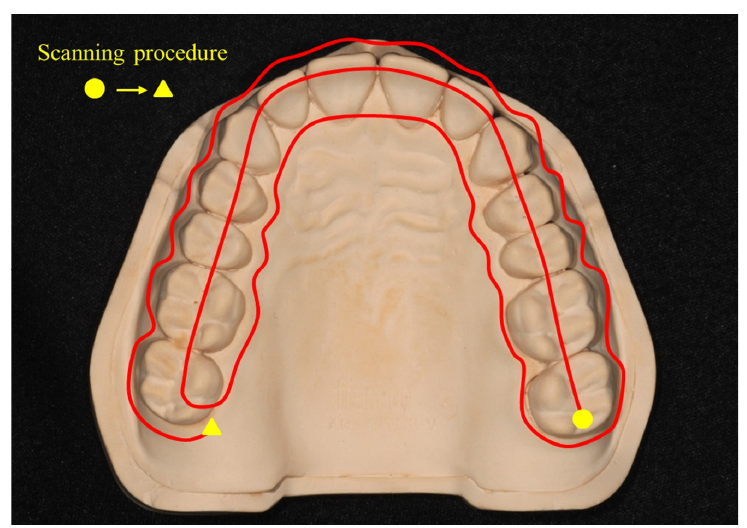
Figure 2. Strategies of complete arch scanning.